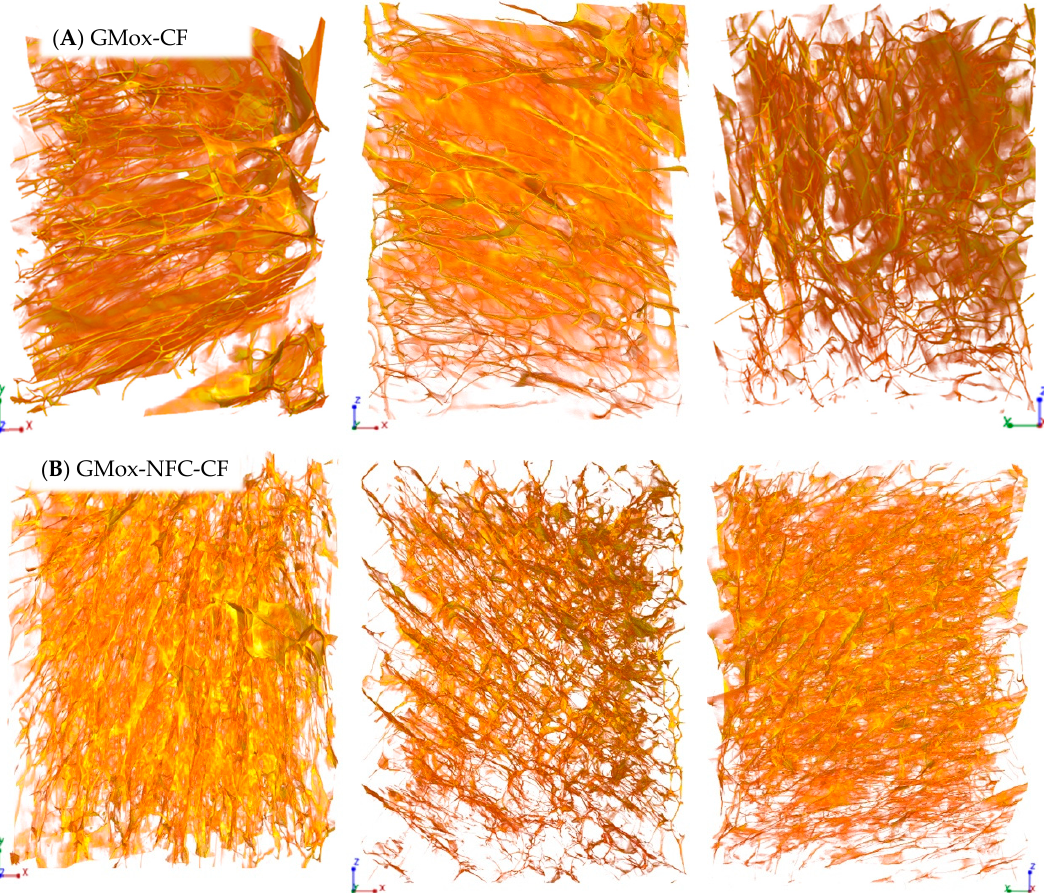
Figure 2. Three-dimensional reconstructed images from synchrotron phase contrast microtomography of ( A ) oxidized guar galactomannan (GM) (GMox) aerogel and ( B ) aerogel reinforced with 25% nanofibrillated cellulose (NFC) (GMox-NFC), prepared by conventional freezing (CF). The size is 495.33 × 495.33 × 660.33 μ m 3 in XYZ-axis.